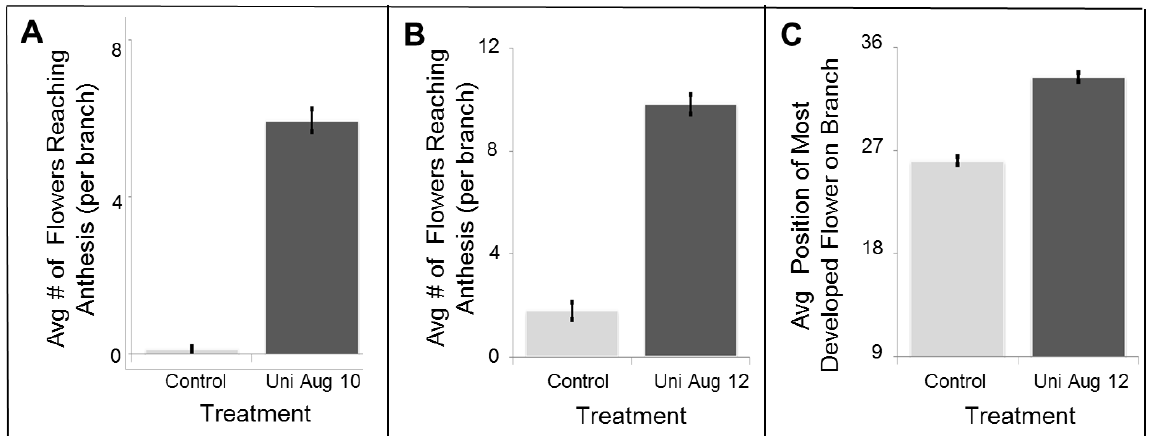
Figure 6. Uni spray on PD vines in commercial orchards (2011). ( A ) Tzipori farm treatments: 200 ppm Uni and surfactant sprayed on 10 August and control untreated plants. The average number of flowers that reached anthesis by September 22 per branch is presented; ( B ) Moranim LTD Treatments: 200 ppm Uni and surfactant sprayed on August 12 and control-untreated plants. The average number of flowers that reached anthesis by September 27 per branch is presented; ( C ) The same experiment as in ( B ), calculating the average relative position from the apex (on September 27) of the first flower reaching anthesis on each branch. A higher number depicts the shielding of additional primordia. Bars in ( A – C ) represent the standard error of the